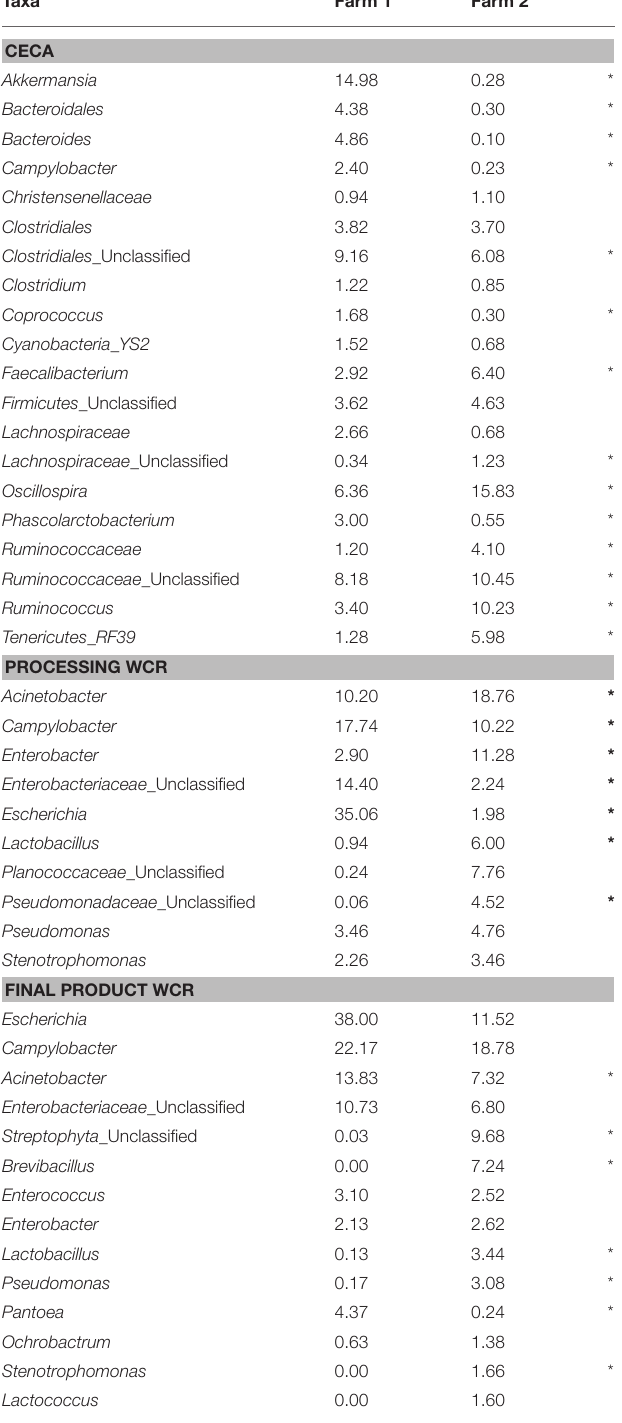
TABLE 5 | Mean relative abundance (%) of dominant genus-level taxa ( > 1% of total OTUs) of processing (ceca, WCR) and final product (WCR) microbiomes from two pastured poultry broiler flocks a,b